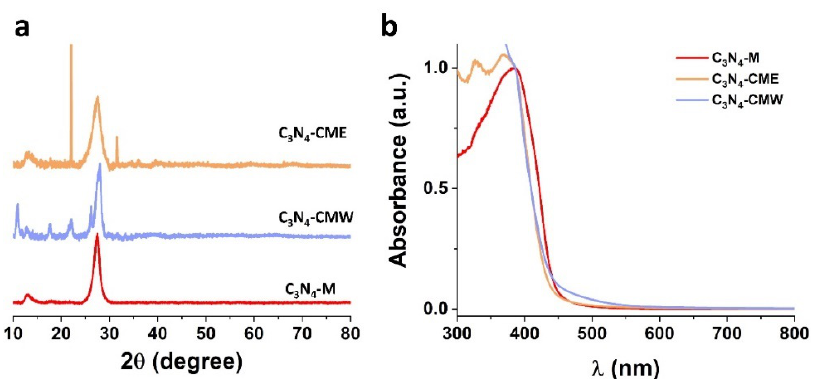
Figure 2. ( a ) XRPD pattern and ( b ) DRS-UV spectra of bare C 3 N 4 -M samples (red line), C 3 N 4 -CMW (light-blue line) and C 3 N 4 -CME (yellow line).